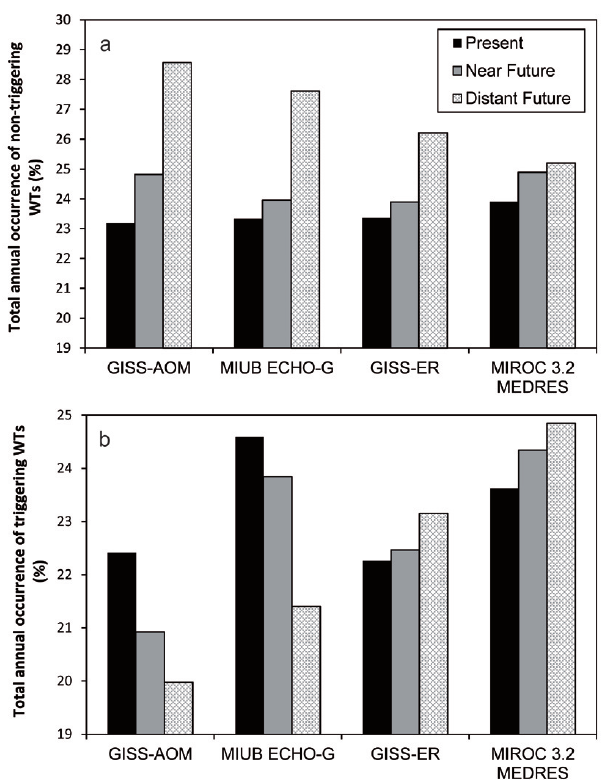
Fig. 11. Total annual occurrence (%) of backflow non-triggering WTs (a) and triggering WTs (b) between the Present and the Near and Distant futures according to the four